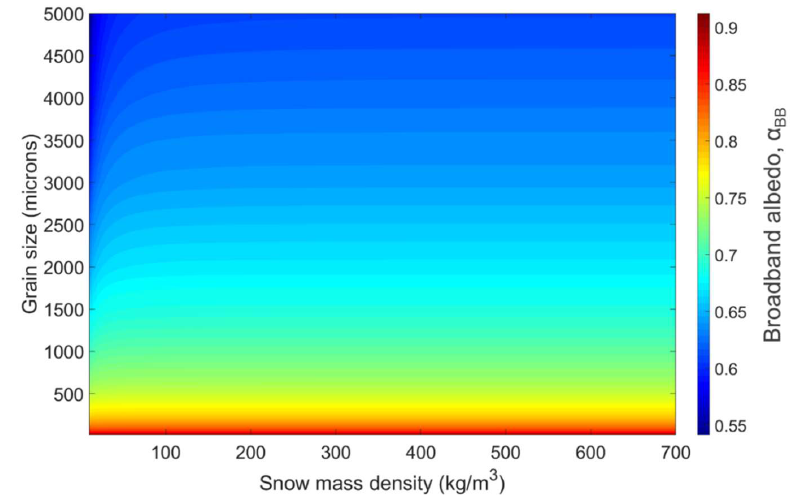
Figure 3. Broadband snow surface albedo α BB as a function of both snow grain radius and snow mass density calculated with the SNICAR model. α BB is largely insensitive to changes in snow density for snow densities greater than ~100 kg/m 3 and grain radii smaller than ~2000 µm. We used SNICAR to calculate broadband surface albedo 𝛼 (cid:3003)(cid:3003) as function of BCMD . The results (Figure 4) show how broadband snow surface albedo decreases as a function of BCMD deposited. The broadband snow surface albedo 𝛼 (cid:3003)(cid:3003) , as a function of the BCMD shown in Figure 4, can be described with less than 1.2% error by a cubic polynomial written as: